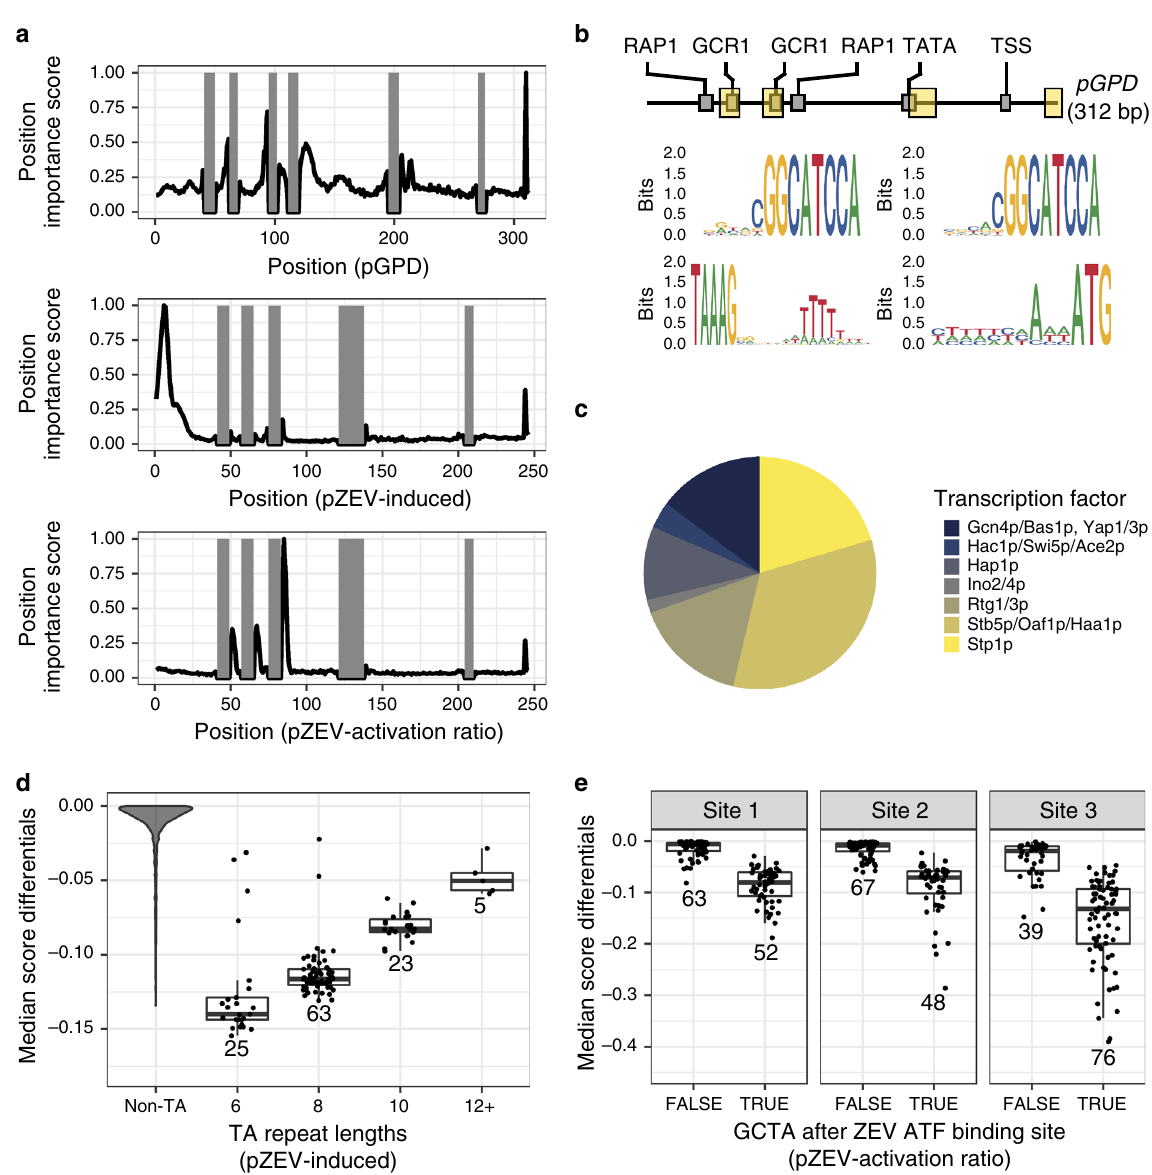
Fig. 5 In silico mutagenesis enables identi fi cation of functional motifs in designed sequences. In panels ( d , e ), boxes represent interquartile ranges; the bar within each box indicates the median. Whiskers extend to the furthest observation within 1.5 interquartile ranges of the nearest box edge. a In silico mutagenesis reveals patterns of predicted position-wise importance in designed sequences. Above: Normalized position-wise scores (averages of scores for each sequence in the design set) for a P GPD design set. Middle: Normalized position-wise scores for a P ZEV -Induced design set. Below: Normalized position-wise scores for a P ZEV -Activation Ratio design set. Gray areas: conserved regions, held constant. b Position-dependent features identi fi ed as sequence logos in P GPD designs. Above: Schematic of the P GPD construct (as in Fig. 1a). Highlighted regions: areas shown in detail below. Sequence logos, top left: Sequence logo for sequence context 5 ′ to fi rst GCR1 site. Top right: Sequence logo for sequence context 5 ′ to second GCR1 site. Bottom left: Sequence logo for sequence context 3 ′ to TATA motif. Bottom right: Sequence logo for sequence context 5 ′ to ATG start codon. c Putative transcription factor binding sites identi fi ed in P GPD designs. Transcription factors with overlapping binding speci fi cities were pooled as described in the